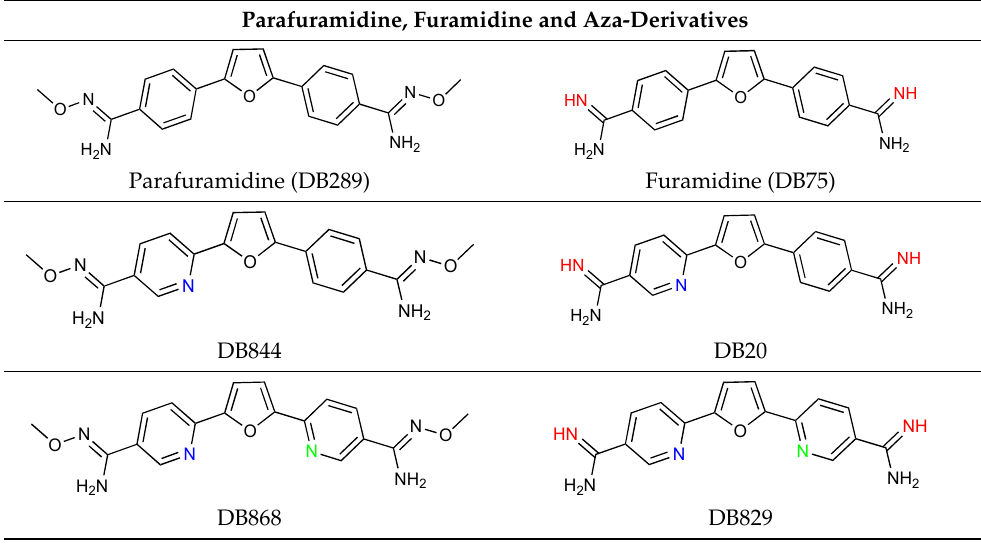
Table 3. Parafuramidine and aza-derivatives in which the colored atoms indicate the structural changes with respect to the drug of reference.